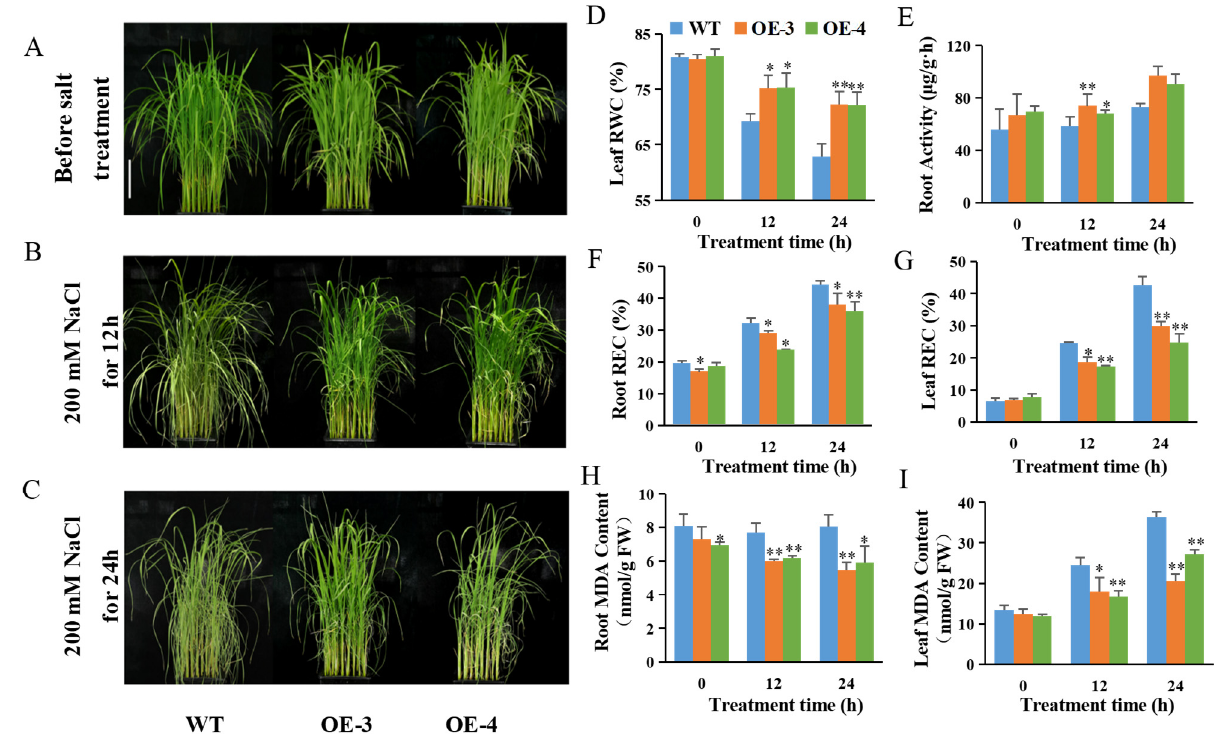
Figure 1. Overexpression of OsABT enhances the salt tolerance of rice seedlings. ( A – C ) Phenotypes of two-week-old OsABT-OE lines (OE-3 and OE-4) and wild-type (WT) plants under 200 mM NaCl for 0, 12 and 24 h. Scale Bar: 5 cm. ( D – I ) Relative leaf water content; root activity; relative root and leaf conductivity; root and leaf malondialdehyde (MDA) content of OsABT-OE lines and WT under 200 mM NaCl for 0, 12, and 24 h. Data are means ± SD of three independent experiments. Asterisks indicate significant differences compared to WT plants at * p < 0.05 and ** p < 0.01 (Student’s t -test).